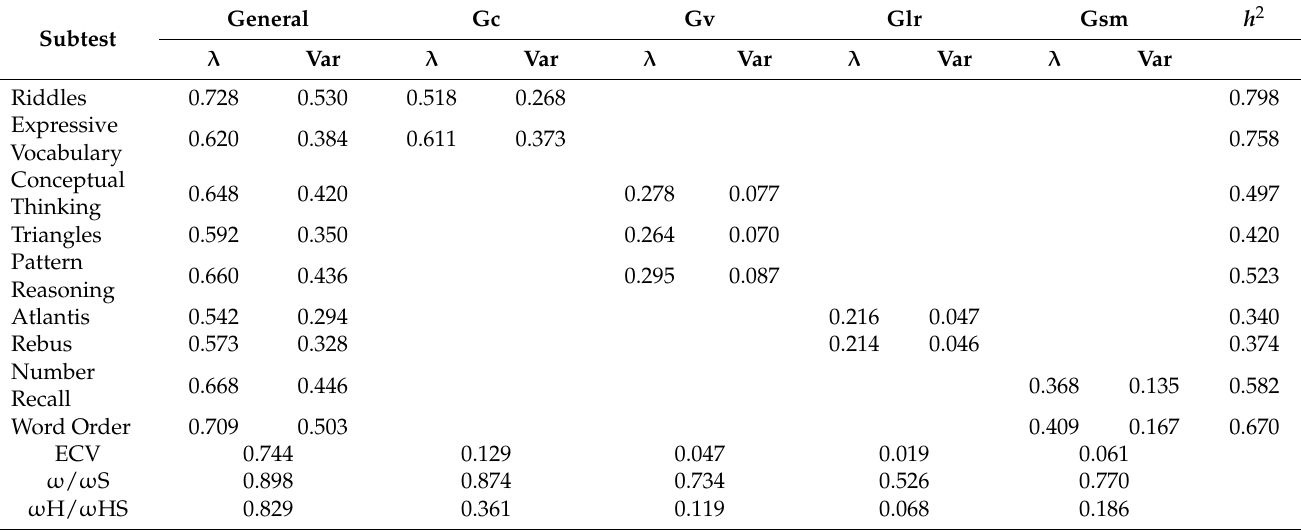
Table 8. Bifactor model of KABC-II core subtests: Factor loadings and sources of variance at age